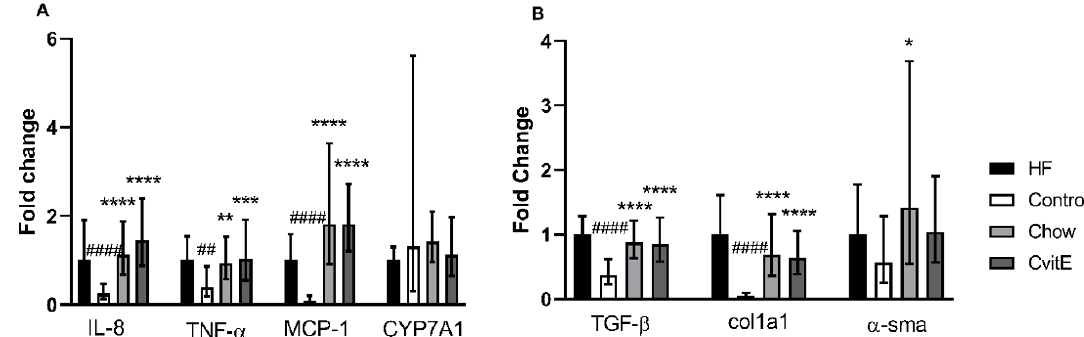
Figure 3. Expression of key target genes. ( A ) Expression of inflammatory target genes (IL-8, TNF- α and MCP-1) showed a significant downregulation in the Control group compared with HF. Furthermore, expression levels in Chow and CvitE were significantly elevated compared with Control, while no di ff erence compared to HF was detected. CYP7A1 expression levels did not show any di ff erence between groups. ( B ) Expression of the fibrotic target genes TGF- β and Col1a1 showed significant downregulation in the Control group compared with HF, while chow and CvitE showed significant upregulation compared with Control with no di ff erence to HF. In the expression of α -sma, Chow was significantly upregulated compared with Control. Moreover, the Control group appeared downregulated compared with HF and CvitE although not reaching significance. * p < 0.05, ** p < 0.01, *** p < 0.001, **** p < 0.0001, compared with Control; ## p < 0.01, #### p < 0.0001, compared with HF. IL-8, interleukin 8; TNF- α , tumor necrosis factor α ; MCP-1, monocyte chemotactic protein 1; CYP7A1, cytochrome P450 7A1; TGF- β , transforming growth factor β ; Col1a1, collagen 1a1; α -sma, α smooth muscle actin.